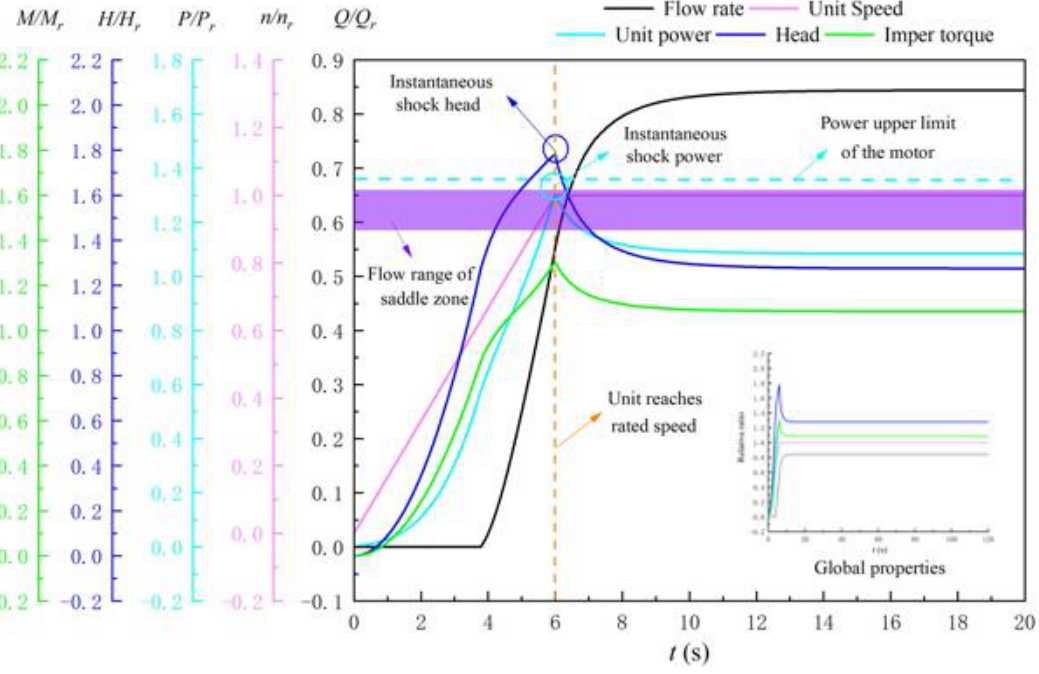
Figure 14. Start-up characteristics curve of LAPS equipped with OVHO (1.04 H m ) and FLVA (49.1% Ag) under gate refusal working conditions.